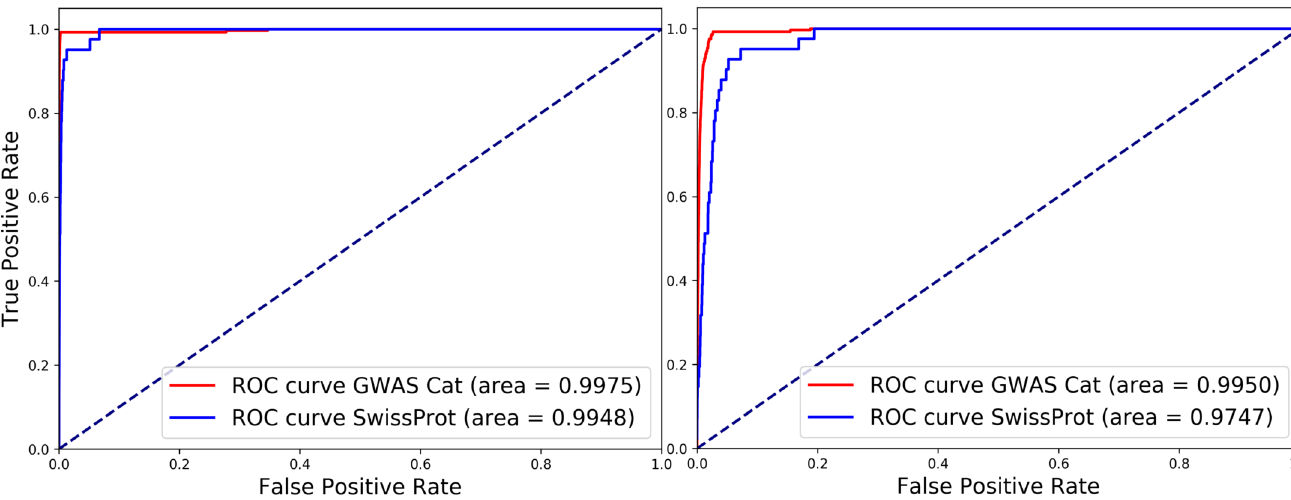
Fig 2. ROC curves of the classification results on the 2017JanJul group of UniProtKB/Swiss-Prot (Blue) and the GWAS Catalog (Red)– (a) Curves in all the publications, (b) Curves in the publications containing mutations at the abstract level.